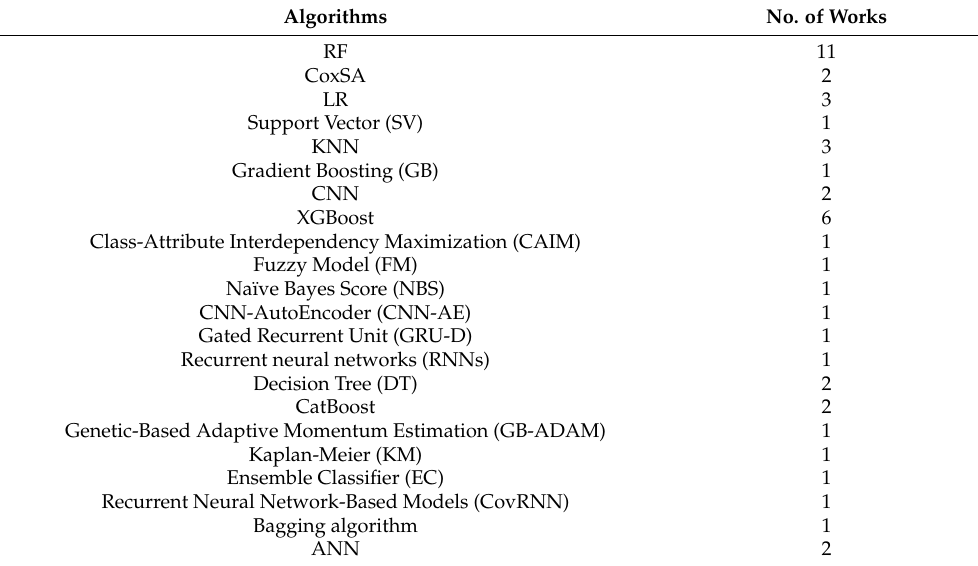
Table 4. Algorithms applied in the reviewed algorithms.